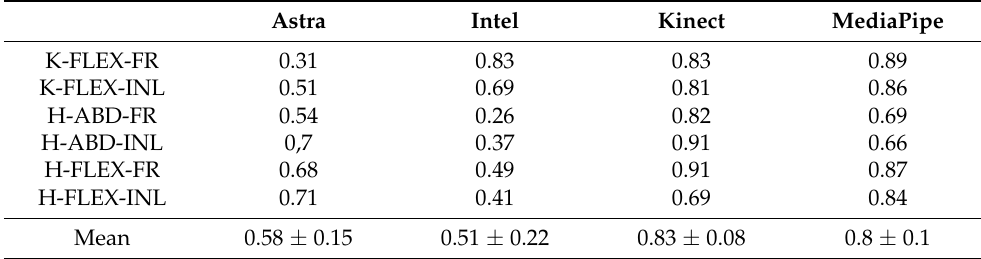
Table 9. Pearson correlation of the sensors for each lower limb movement; p -value < 0.001 for all Pearson correlationmatrices.